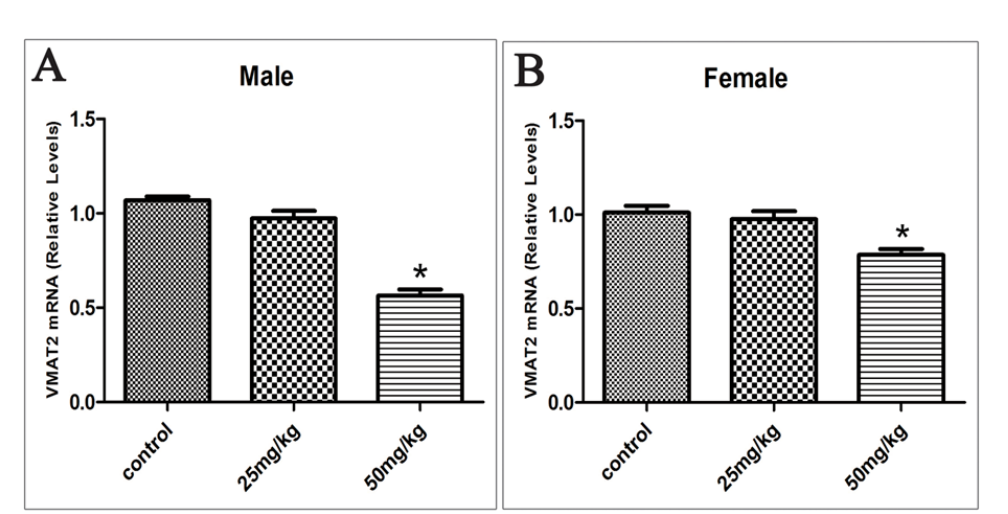
Figure 4. Offspring’s VMAT2 mRNA relative expression levels in the ventral midbrain in males ( A ) and females ( B ) exposed to ATR during gestation and lactation. ( n = 10) * p < 0.05.